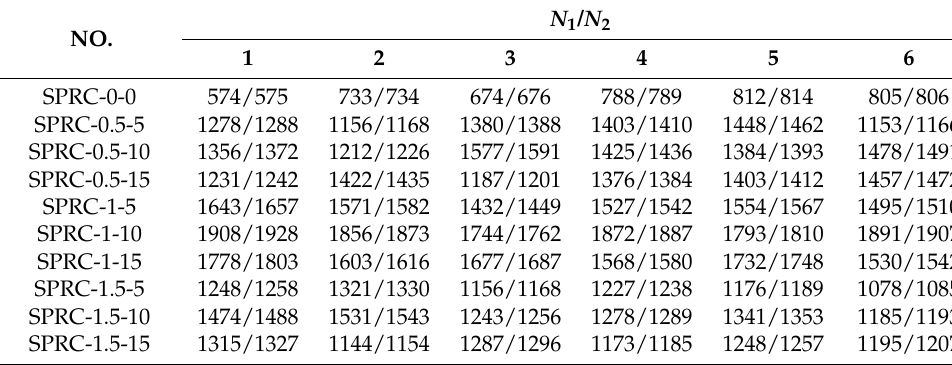
Figure 5. The error bars in the figure are the standard deviations, and the error bars indicate data dispersion: smaller error bars indicate smaller data dispersion.